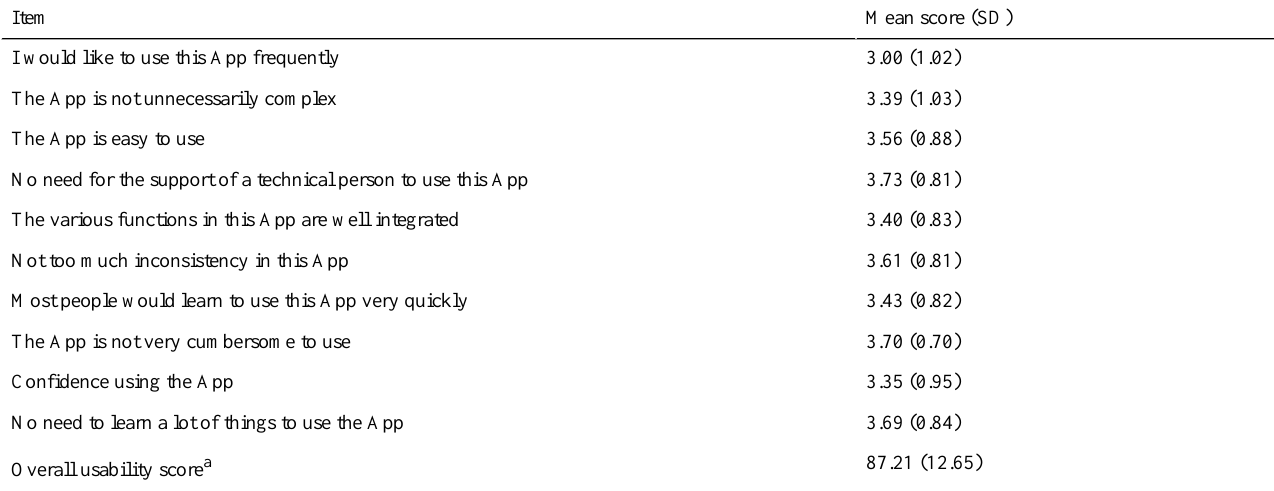
Table 5. Usability of the PsyCovidApp intervention by the PsyCovidApp group (n=221) measured with the System Usability Scale (the theoretical score range is 0-4 for single items; higher scores are indicative of higher